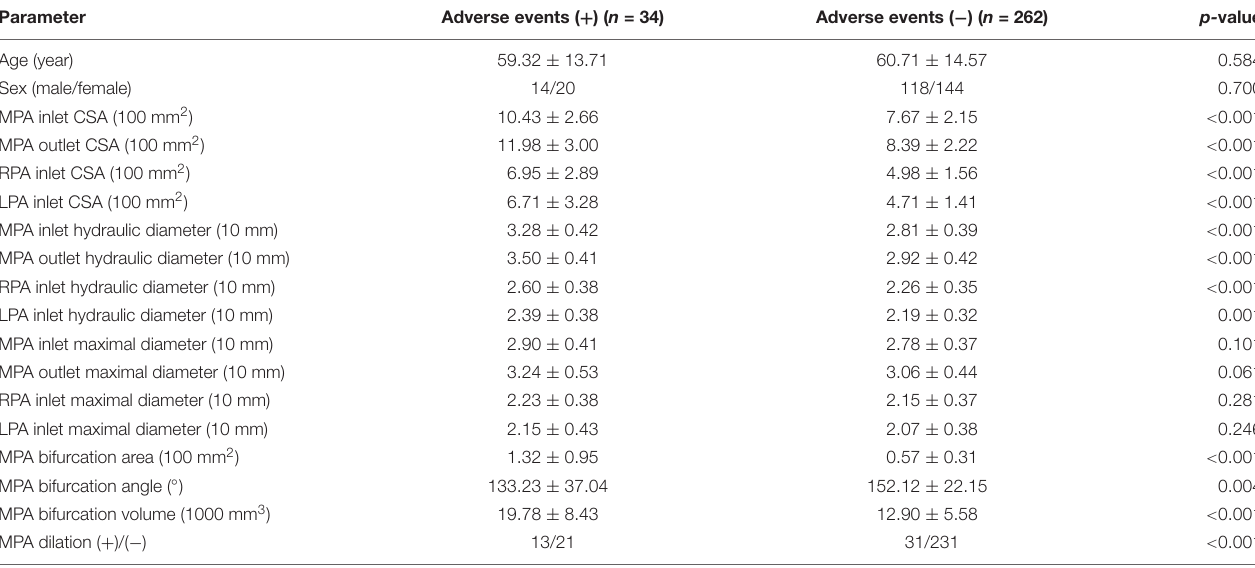
TABLE 1 | Comparison of parameters between adverse events ( + ) patients and adverse events ( − ) patients.